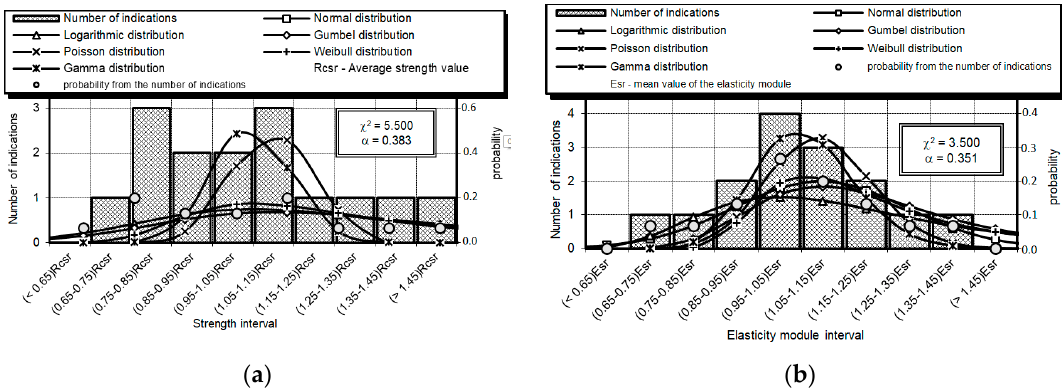
Figure 1. Histogram of the results of laboratory tests ( a ) for the compressive strength of sandstone with verification of the statistical hypothesis consistency for the normal distribution. Reproduced from [32], Wyd. Politechniki Ś l ą skiej: 2007, ( b ) the sandstone elasticity modulus with verification of the statistical hypothesis consistency for the normal distribution Reproduced from [32], Wyd. Politechniki Ś l ą skiej: 2007.